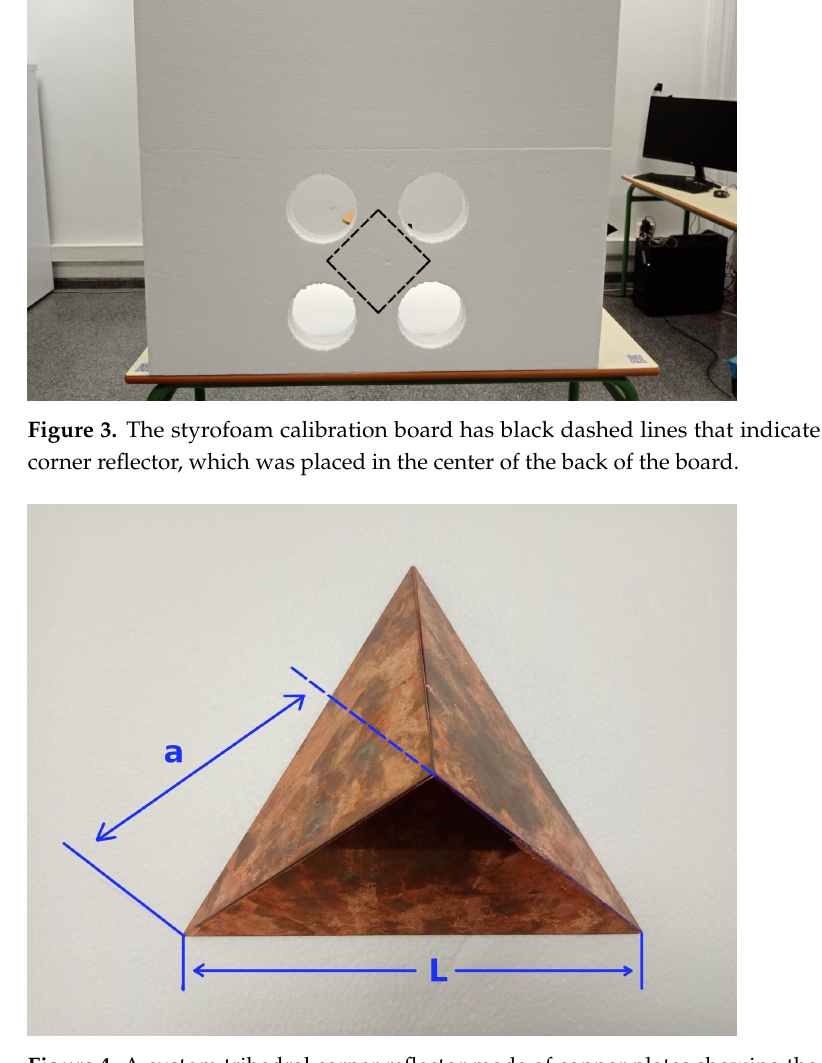
Figure 4. A custom trihedral corner reflector made of copper plates showing the side length edge of the three isosceles triangles ( a ) and the base of the triangles ( L )